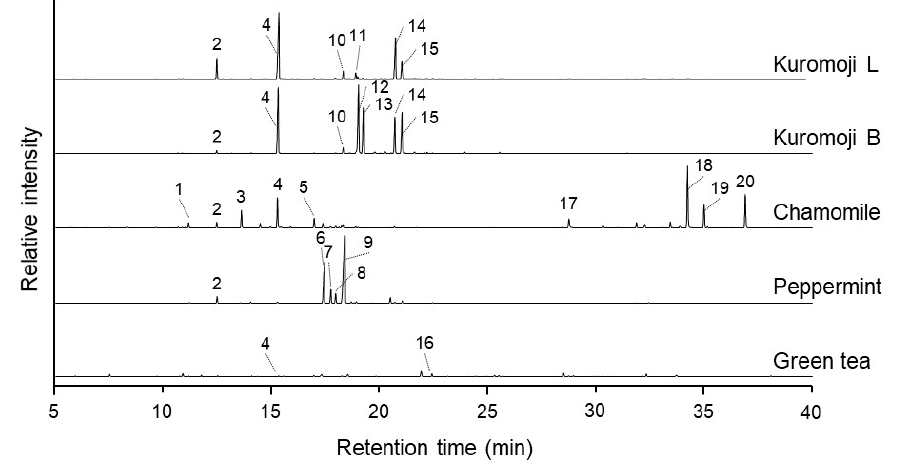
Figure 2. Headspace–solid-phase microextraction (HS-SPME)/gas chromatography–mass spectroscopy (GC–MS) chromatograms of the experimental materials used in this study. Numbers accompanying each peak indicate the peak number in Table 1.